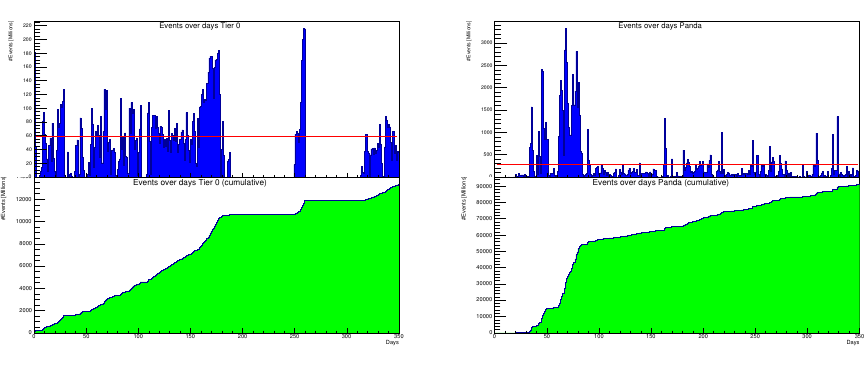
Figure 2: Tier-0 processed events Figure 3: Grid processed